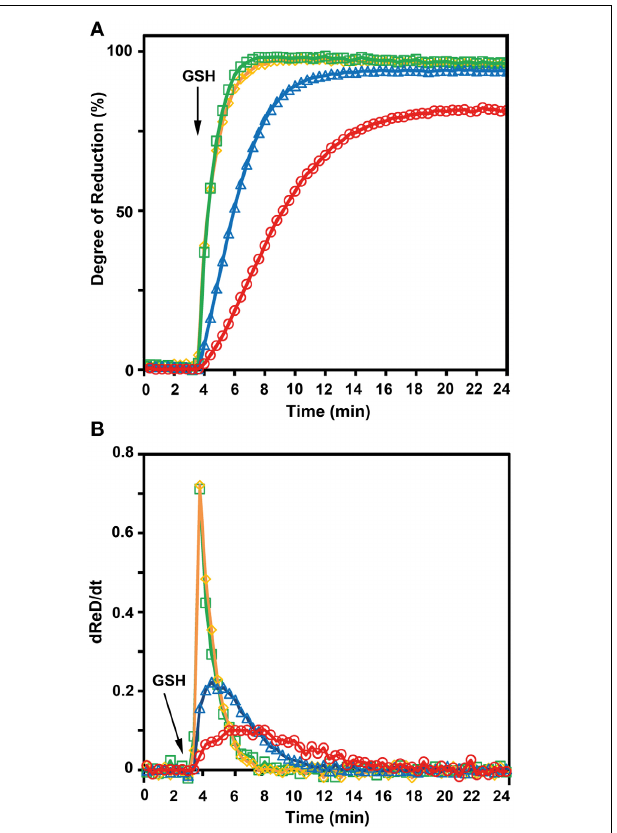
FIGURE 7 | GSH-dependent reduction of roGFP variants. The kinetics for the reduction of roGFP by reduced glutathione strongly depends on redox potential of the disulfide forming cysteines of the respective roGFP sensors. (A) The excitation ratio 390/480nm with emission at 520nm was followed over time. Fully reduced glutathione (final concentration 5mM) was added to a solution of pre-oxidized roGFP1-iL ( (cid:4) ), roGFP2-iL ( ♦ ), roGFP2 ( (cid:6) ), and roGFP1 ( ◦ ) 3.75min after start of the measurement. The reaction buffer contained 2 μ M GRX, 100 μ M NADPH, and glutathione reductase at pH 7.4 to maintain maximum reduction of glutathione over the measured time course ( n = 4). (B) dRed/dt further illustrates the rapid change in reduction of roGFP1-iL ( (cid:4) ) and roGFP2-iL ( ♦ ) compared to roGFP2 ( (cid:6) ) and roGFP1 ( ◦ ).